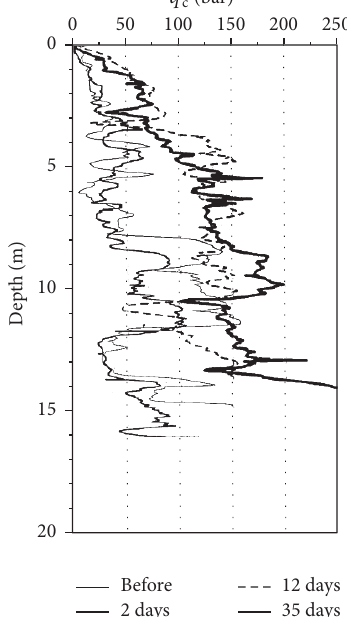
Figure 8: Time dependency of CPT cone tip resistance 𝑞 Quebec HQ SM-3 Dam